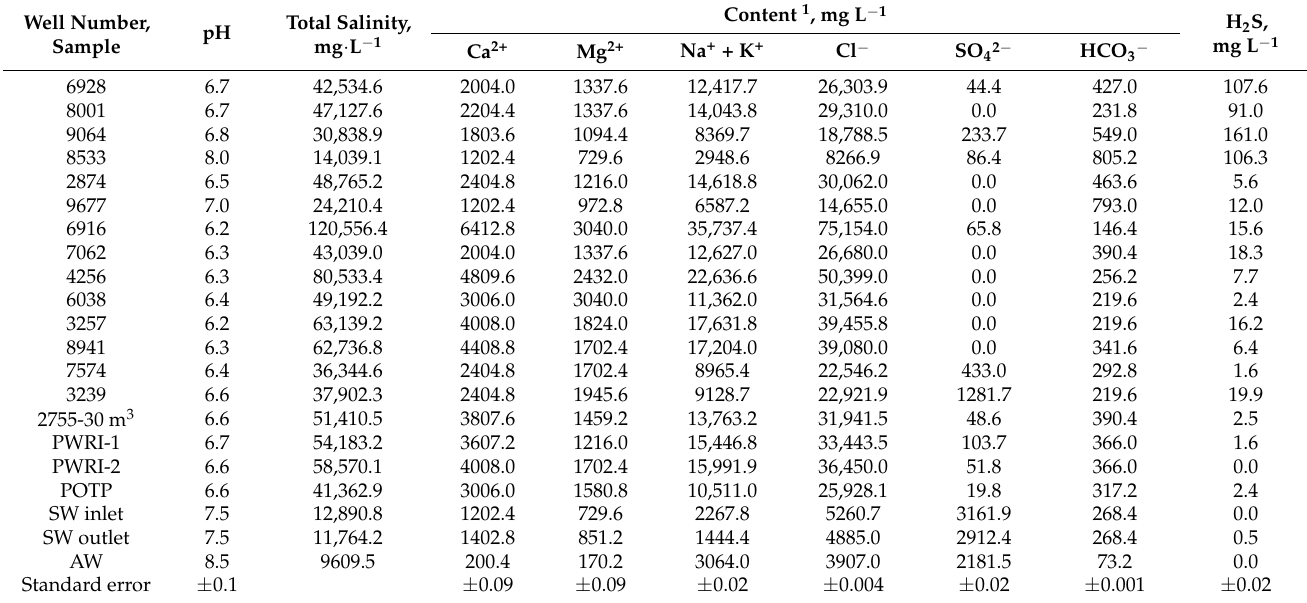
Table 1. Physicochemical characteristics of production and injection water samples from the Uzen oil field. Well Number,